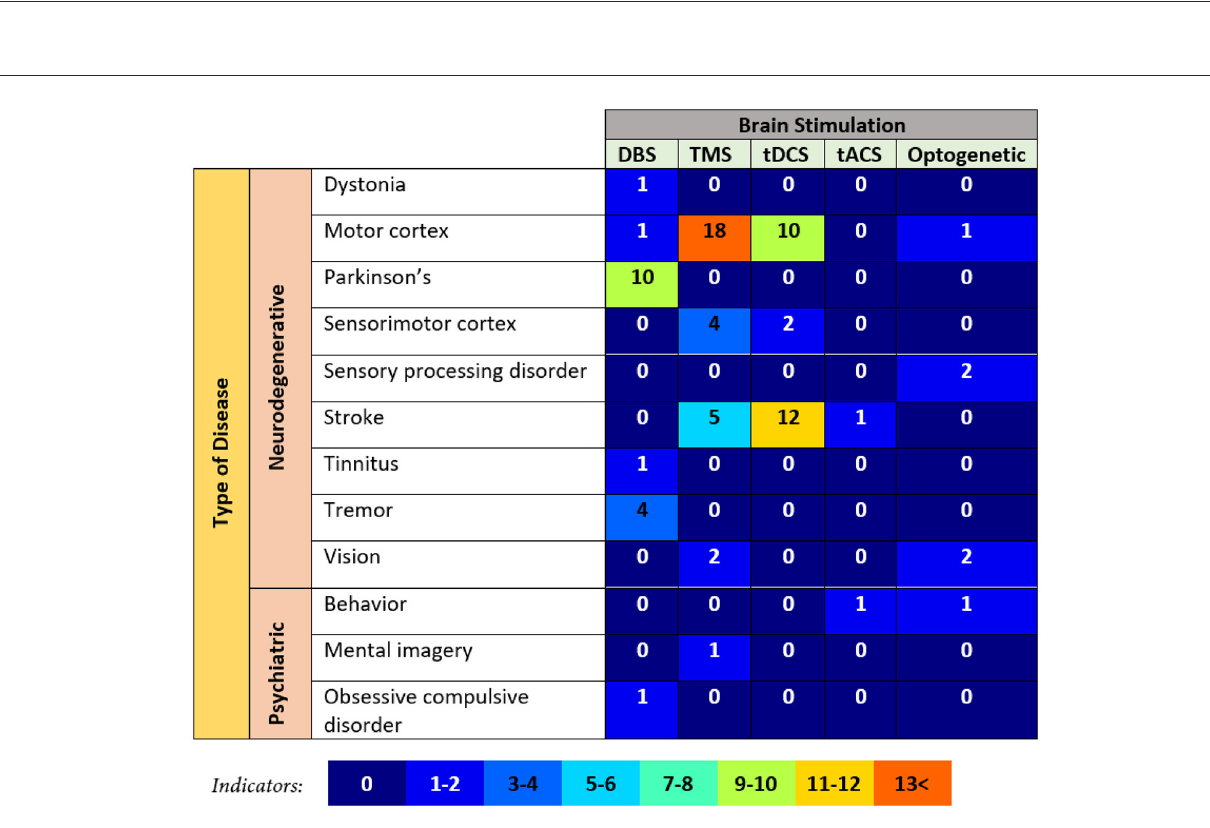
FIGURE6 Distribution of articles selected according to the brain stimulation and type of disease. DBS, deep brain stimulation; TMS, transcranial magnetic stimulation; tDCS, transcranial direct current stimulation; tACS, transcranial alternating current